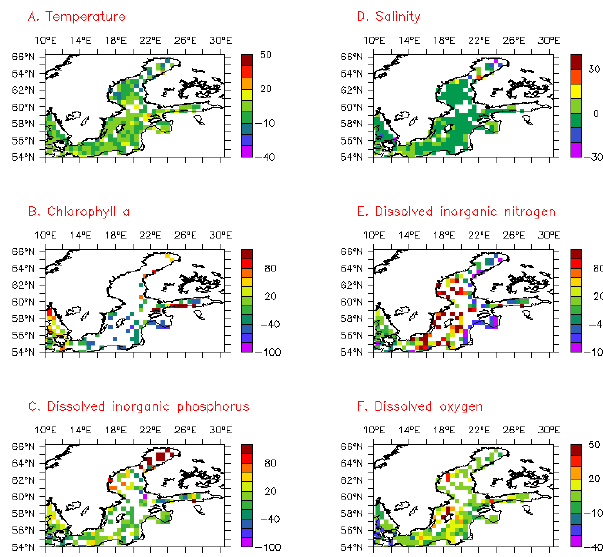
Fig. 16. Horizontal pattern of model’s percentage errors. Panels (A–F) for temperature, Chl a , DIP, salinity, DIN, DO, respectively. Units